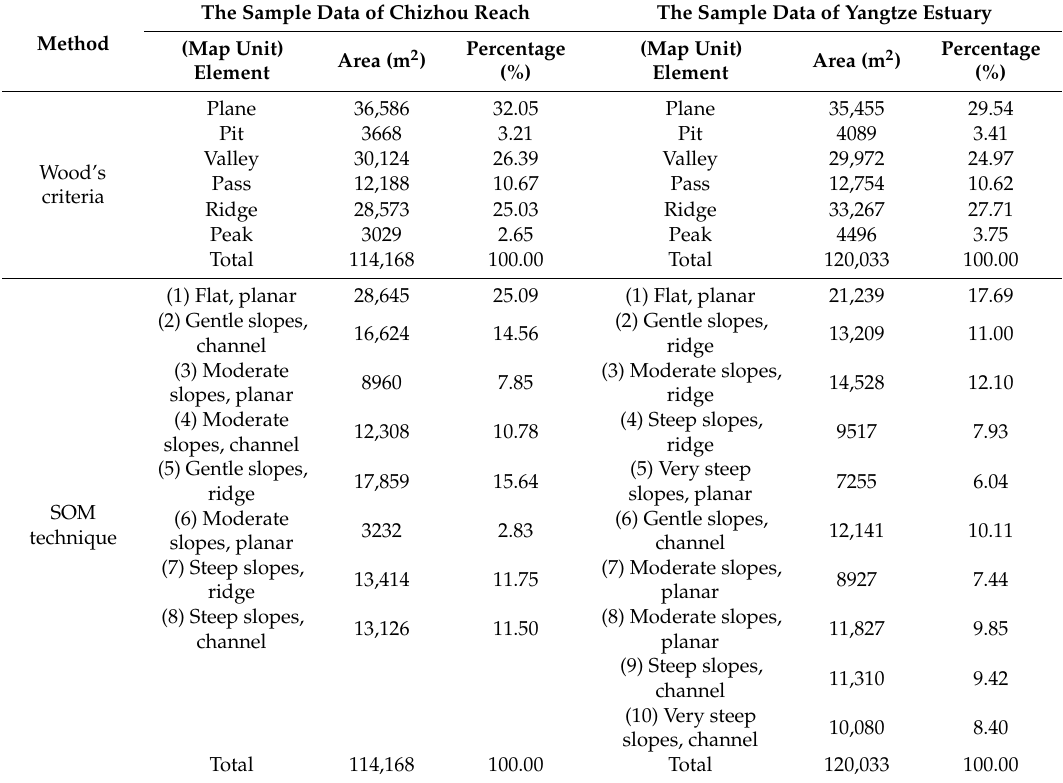
Table 2. Statistical results for geomorphic elements under Wood’s criteria, the SOM technique, and geomorphons.